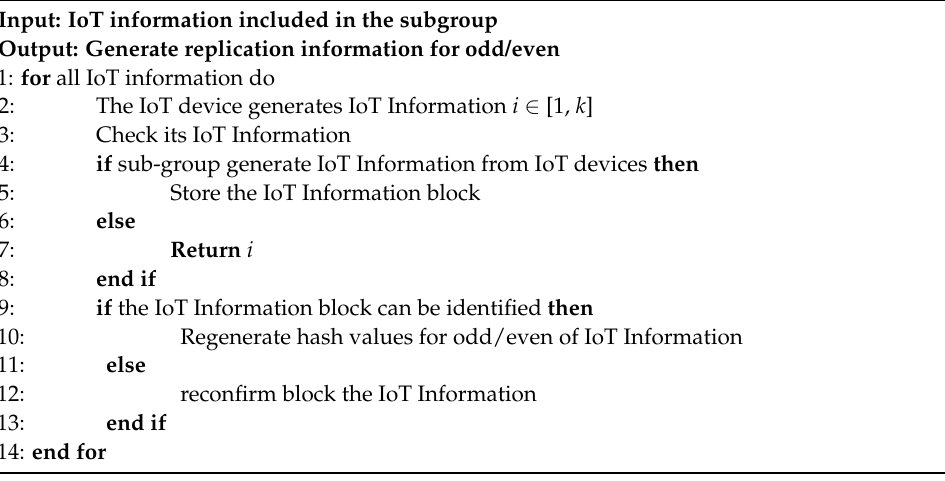
Algorithms 1 Block generation algorithm for IoT information.